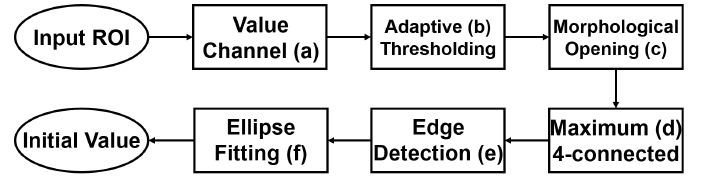
Figure 16. The flowchart of initial-value detection (( a – f ) correspond to the images in Figure